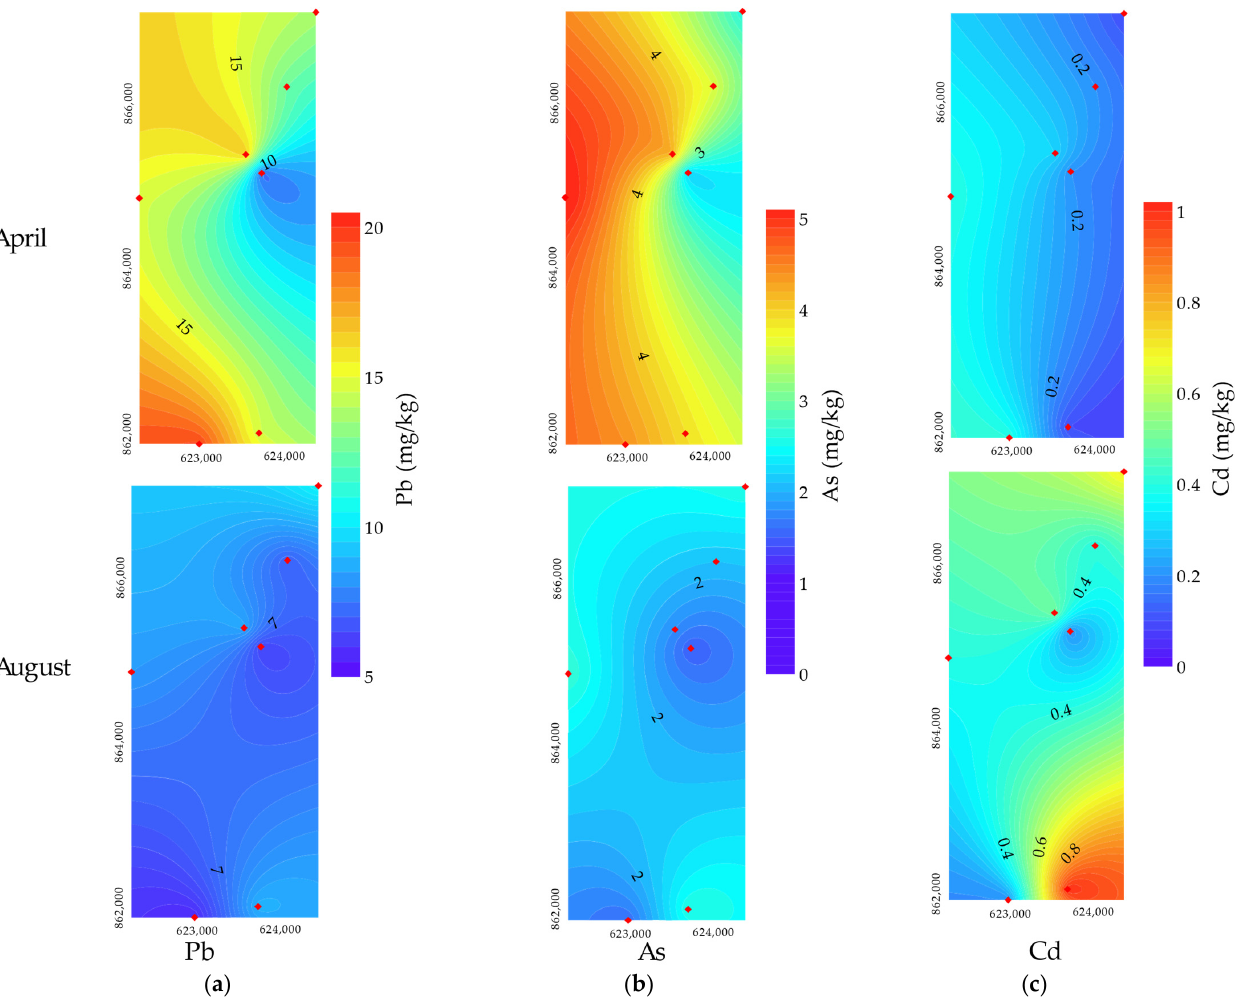
Figure 2. Heavy metal distribution (mg/kg dry weight) in the sediment cores of the Khuan Khi Sian wetland: ( a ) Pb, ( b ) As, and ( c ) Cd. (Note: April = dry season; August = wet season.)